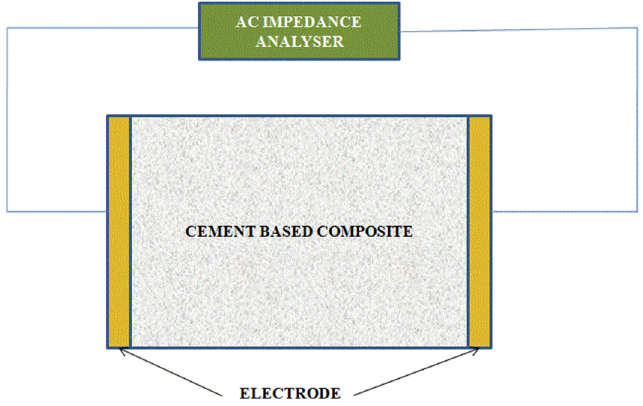
Figure 12. The specimen setup for AC impedance analysis.